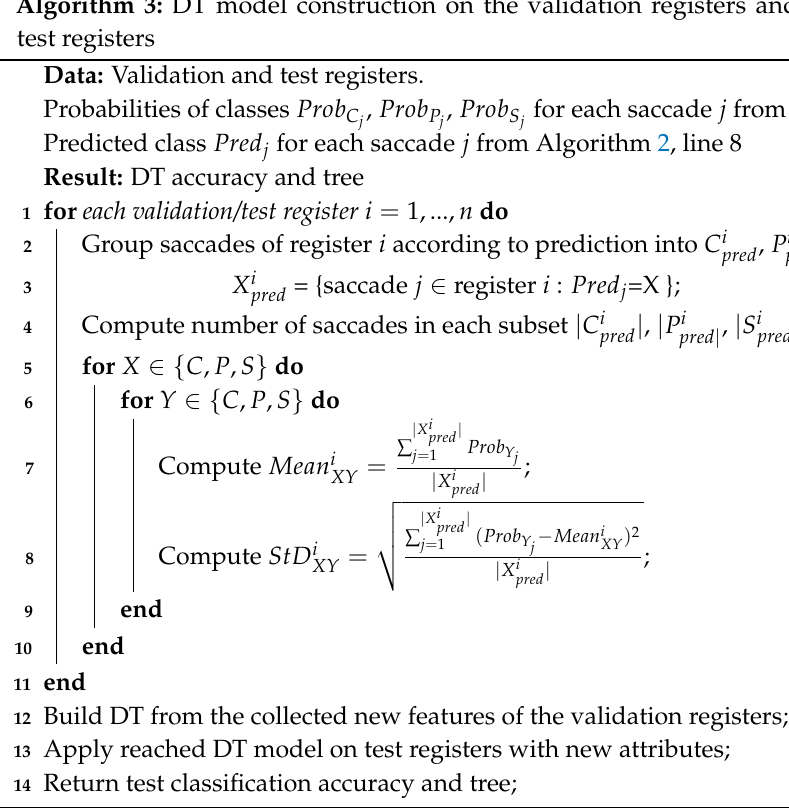
Algorithm 3: DT model construction on the validation registers and prediction on